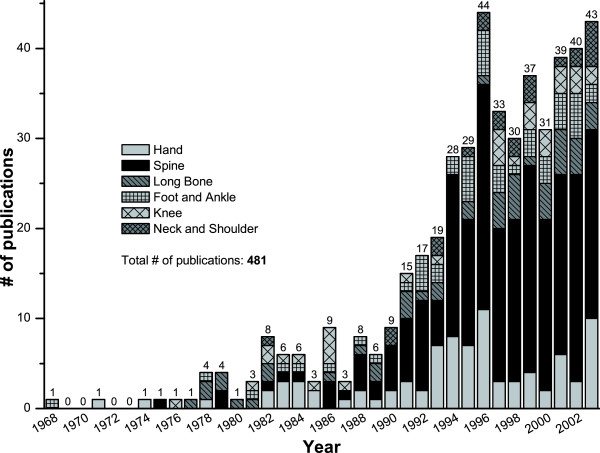
Number of publications of studies with RTW as outcome parameter. Pubmed-search from 1966 – 12/2003 using the search strategies: (1) [('return' OR 'day* lost' OR 'disability') AND 'work'] OR 'sick leave'; Limit: 'Clinical Trial' (2) {[('return' OR 'day* lost' OR 'disability') AND 'work'] OR 'sick leave'} AND 'Orthopaedic Procedures [mh]'. The abstracts of the retrieved publications were scanned to identify clinical studies using either 'return to work' or 'time of sick leave' as primary or secondary outcome. The found studies were categorised into one of the following 6 groups: 'Hand', 'Spine', 'Long Bone', 'Foot and Ankle', 'Knee' or 'Neck and Shoulder'.